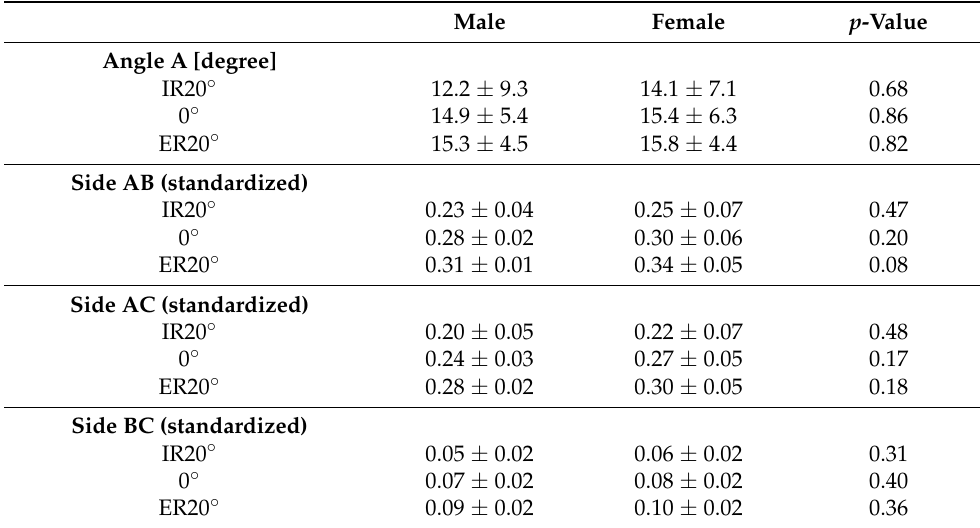
Figure 2. Comparison of three sides and the angle of confluences of both heads of the biceps brachii at three shoulder positions. ( A – C ): Distances of Sides AB, AC, and BC. ( D ): Angle A. The measured distances of Sides AB, AC, and BC were standardized by dividing them by the humeral length. Angle A was calculated from Sides AB, AC, and BC using the cosine theorem and then compared among the three shoulder positions. ER, external rotation; IR, internal rotation; * p < 0.0001. Table 3. Comparisons of Angle A and standardized Sides AB, AC, and BC by